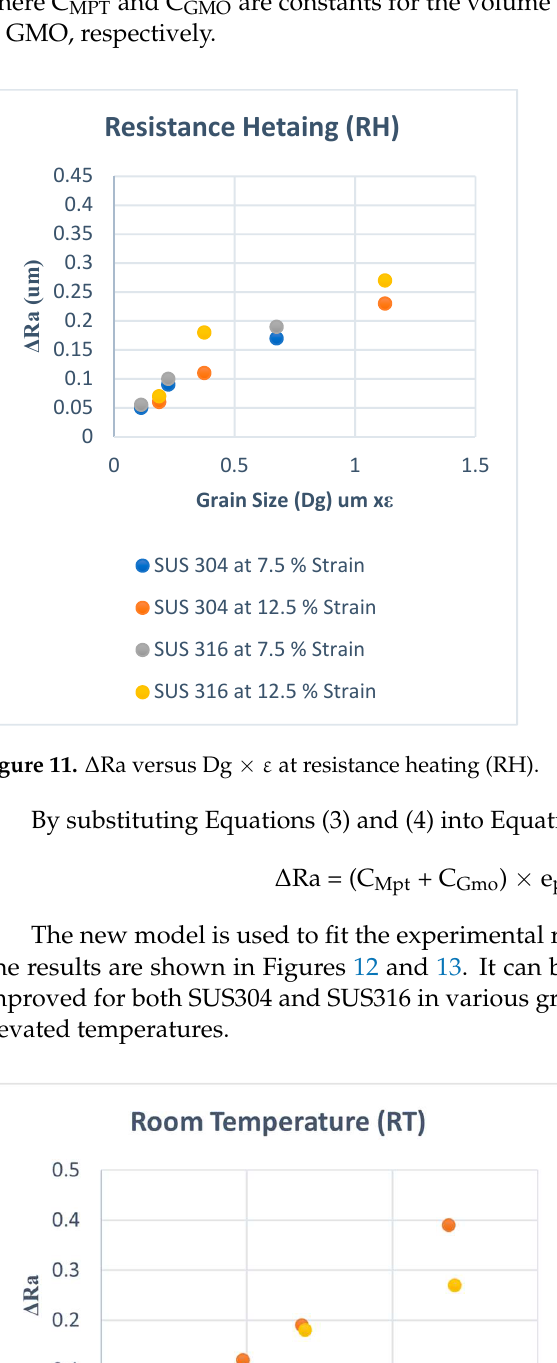
Figure 10. Δ Ra versus Dg × ε at room temperature (RT).